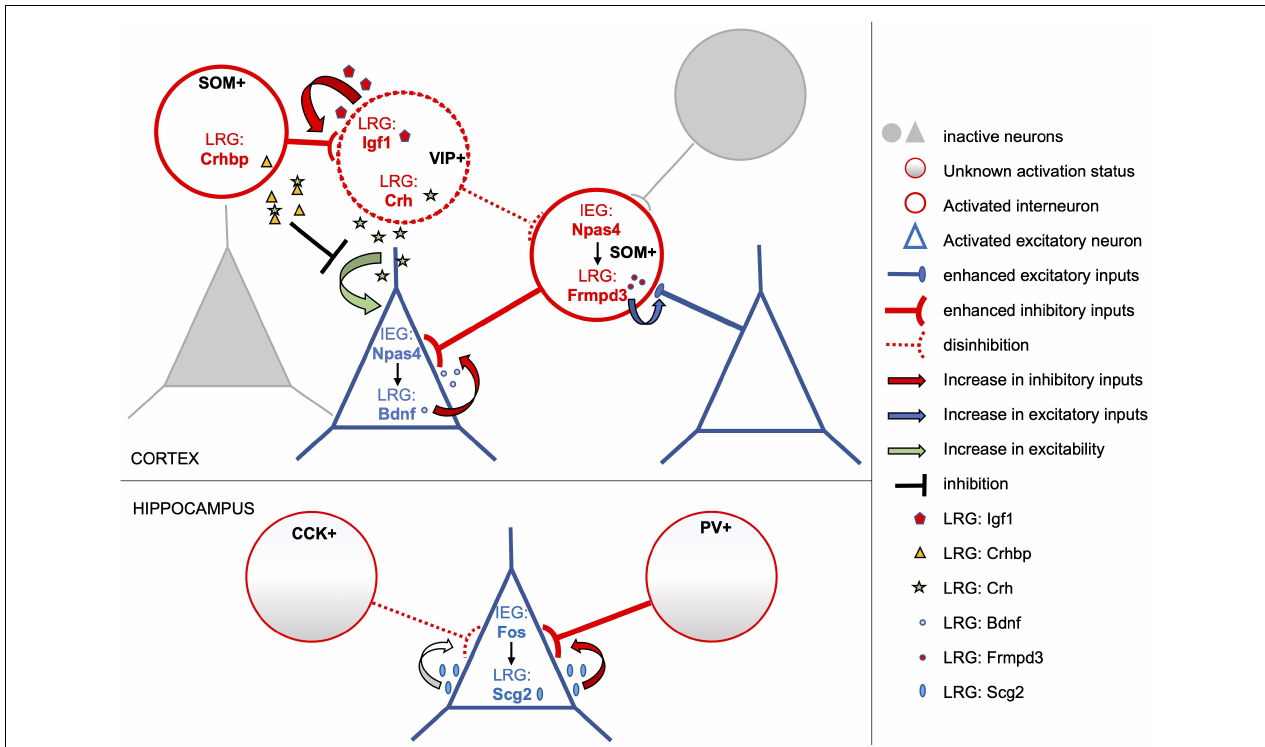
FIGURE 1 | Subtype-specific activity-dependent transcriptional programs shape circuit rearrangements in response to experience. The model depicts examples of activity-induced LRGs which modulate connectivity and/or excitability of distinct neuronal subtypes, overall enhancing the inhibitory tone onto activated pyramidal neurons. Excitatory and inhibitory neurons of the activated neuronal ensemble are depicted as blue triangles and red circles, respectively. In cortical excitatory neurons the IEG Npas4 drives expression of several LRGs including Bdnf (blue dots), which in turn promote an increase in the number of inhibitory inputs onto these cells. Conversely, Npas4 expression in activated SOM + inhibitory neurons triggers a transcriptional program that includes the LRG Frmpd3 (red dots), which induces an increase in excitation onto the GABAergic cell (Spiegel et al., 2014). Activity-dependent transcriptional profiles of cortical VIP + interneurons include the LRGs Igf1 (red pentagons) and Crh (green stars). Secreted Igf1 promotes inhibition of VIP + neurons (Mardinly et al., 2016), which often operate by disinhibiting principal neurons. On the other hand, VIP + neurons also release Crh which can increase the excitability of nearby pyramidal cells. However, this effect may be tampered by Crhbp (yellow triangles), an inhibitor of Chr secreted by SOM + neurons in response to stimulation (Hrvatin et al., 2018). Overall, activity-dependent transcriptional responses of both excitatory and inhibitory cortical neurons appear to converge in increasing the inhibitory tone onto activated excitatory neurons. Similarly, in the hippocampus, Fos expression in activated excitatory neurons induces the LRG Scg2, a precursor to four neuropeptides, which increases perisomatic inhibition by PV-interneurons albeit weakening that of CCK-interneurons (Yap et al., 2021).